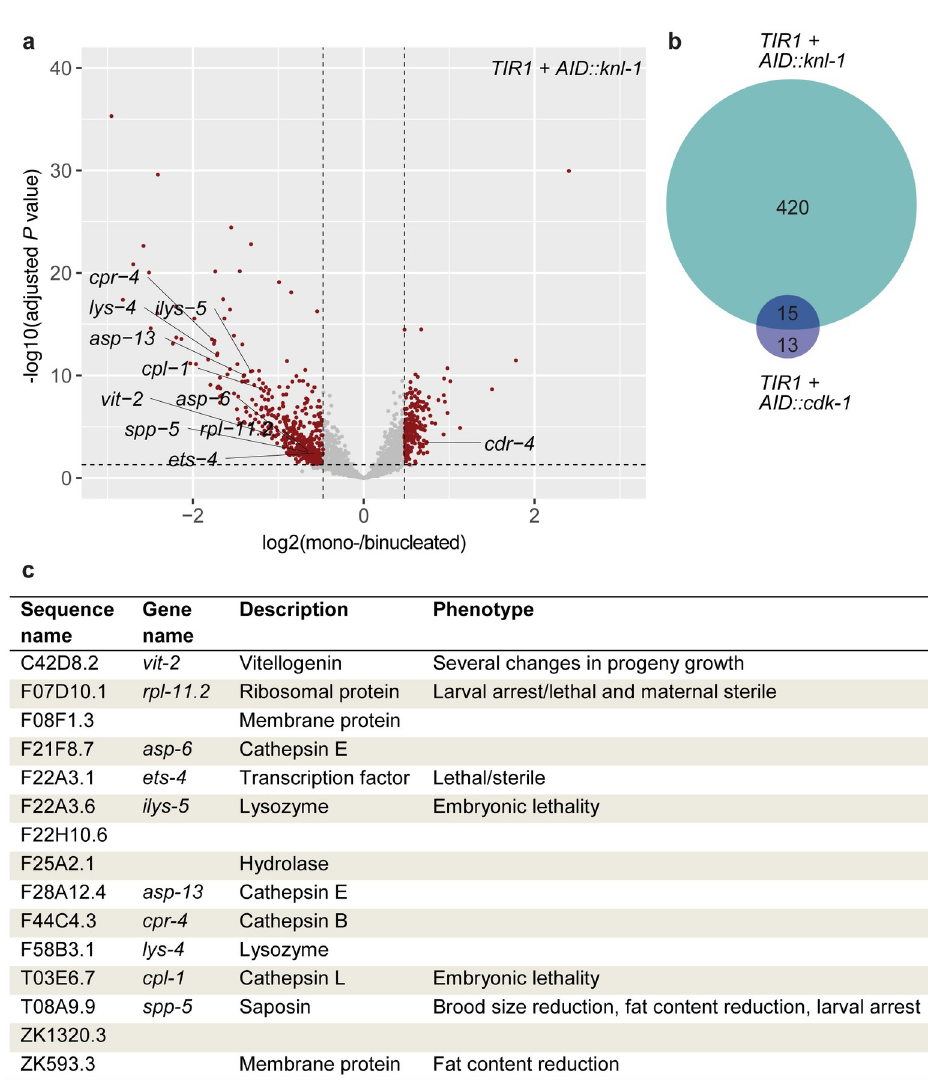
Fig 3. Blocking binucleation causes transcriptional down-regulation of intestinally expressed genes in young adult C . elegans . (A) Volcano plot of RNA sequencing data depicting the transcriptional gene up- and down-regulation in worms with a mononucleated intestine, compared to worms with a binucleated (wild type) intestine in Pges-1 :: TIR1; AID :: knl-1 animals ( n = 68). After filtering for coverage, batch consistency, and intestinal expression, 2,638 genes were analyzed for differential gene expression using DEseq. Red dots represent genes significantly differentially expressed (adjusted P value < 0.05, top 25% absolute log2(foldchange)). Genes significantly differentially expressed in both Pges- 1 :: TIR1; AID :: knl-1 and Pges-1 :: TIR1; AID :: cdk-1 comparisons were individually annotated with their gene name (excluding genes without a gene name). (B) Venn diagram of the overlap of significantly down-regulated genes in Pges-1 :: TIR1; AID :: knl-1 and Pges-1 :: TIR1; AID :: cdk-1 animals. (C) Overview of genes that are found to be significantly down-regulated in worms in which intestinal binucleation is blocked, both by degradation of CDK-1 and